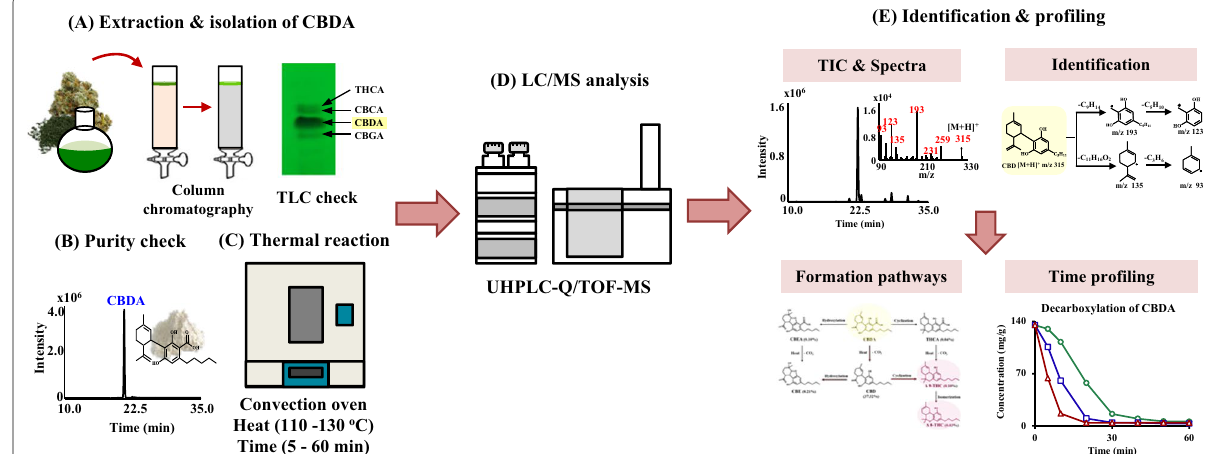
Fig. 1 Overall analytical procedure of thermal reaction for acidic cannabinoids. A extraction & isolation of CBDA, B purity check, C thermal reaction, D LC/MS analysis, and E identification &